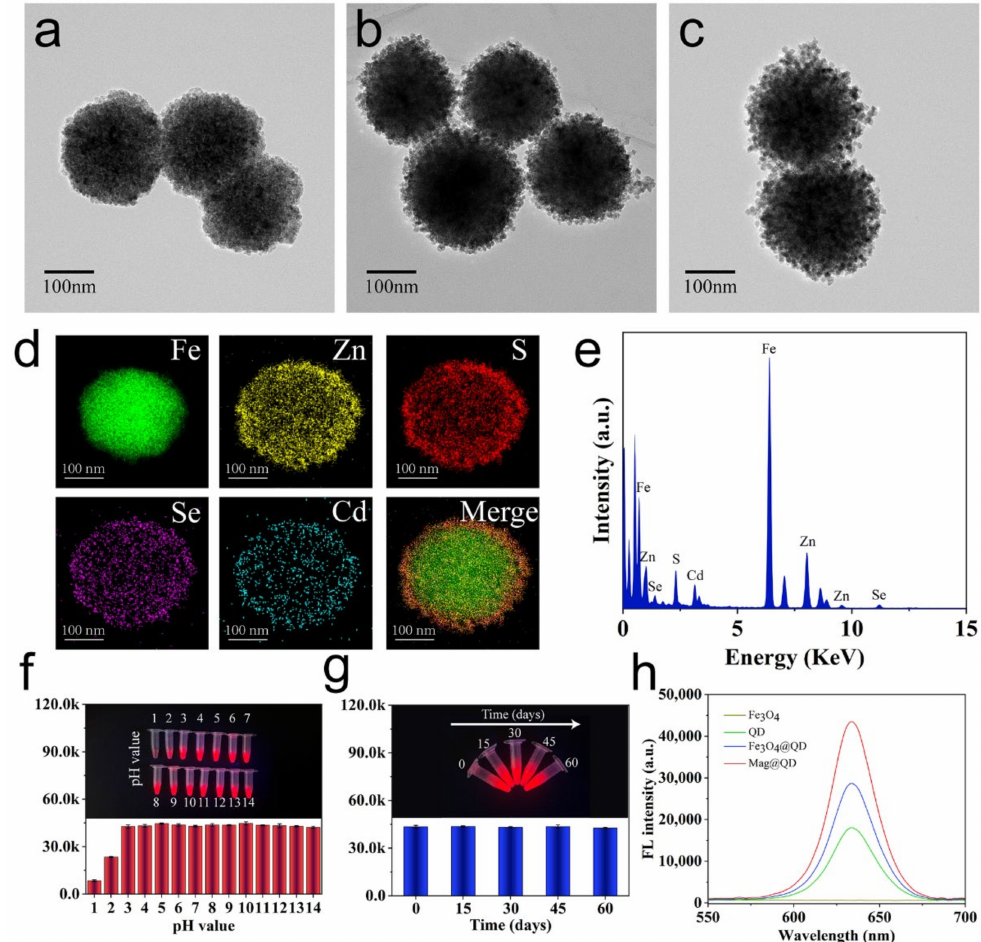
Figure 1. TEM images of ( a ) Fe 3 O 4 , ( b ) Fe 3 O 4 @QD, and ( c ) Mag@QD. ( d ) Elemental mapping images and ( e ) EDS spectrum of Mag@QD. ( f ) Fluorescence images and intensities of Mag@QD at different pH values. ( g ) The fluorescence intensity of Mag@QD dispersed in ethanol against preservation time. ( h ) Fluorescence emission spectra of Fe 3 O 4 , QD, Fe 3 O 4 @QD, and